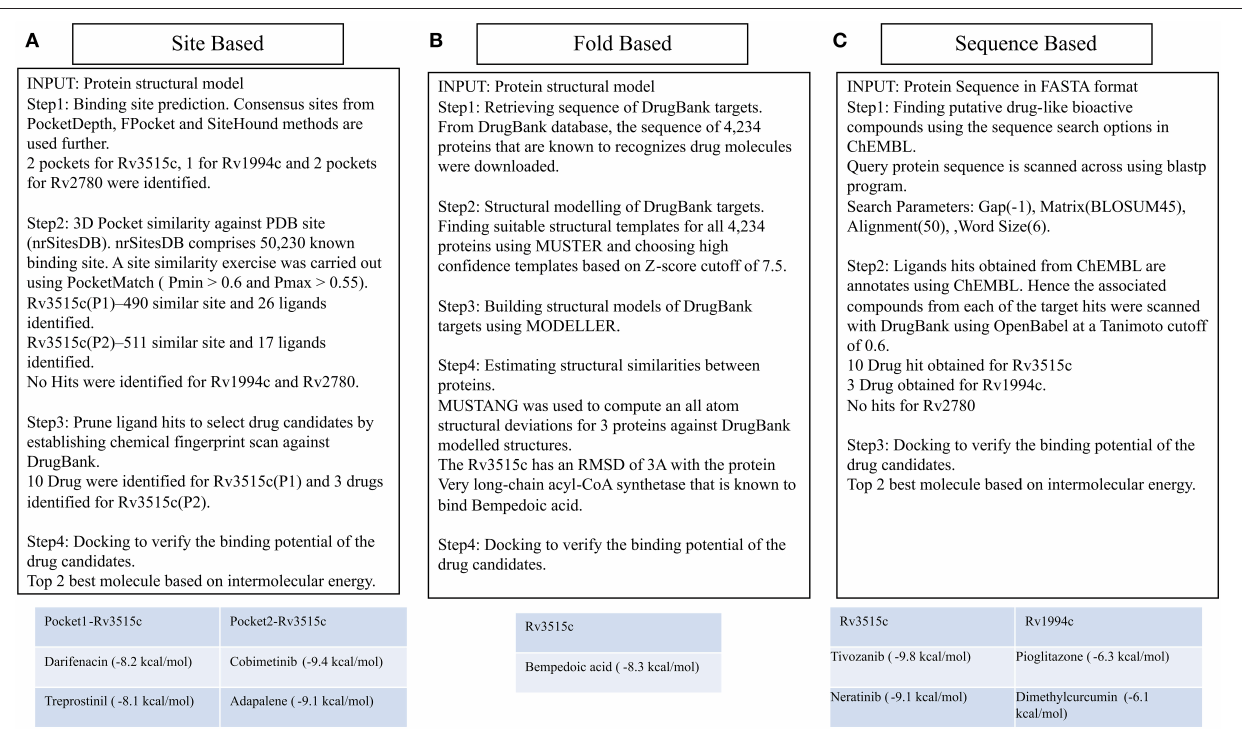
FIGURE 5 | Different ways of associating targets with DrugBank drugs. The site-based association uses binding site similarity as a metric for assigning function to a protein. Consensus pocket prediction exercise yields two pockets for the protein fadD19 (Rv3515c), 1 pocket for cmtR (Rv1994c), and two pockets for ald (Rv2780). Site matching exercise on PDB site library gave 43 ligands that could bind with fadD19. Ligand hits were then pruned by establishing chemical fingerprints on DrugBank molecules. Cobimetinib and darifenacin came out as the best repurposable drug candidate for fadD19. No hits were identified for ald and cmtR. Fold based annotation involves mapping drugs to the targets from the known drug binding proteins. The 3D structure of 4,234 proteins was built using MUSTER and MODELER, of which one hit, very long-chain acyl-CoA synthetase, binding to bempedoic acid share a fold level similarity with fadD19. No hits were identified for ald and cmtR. Finally, sequence derived analysis uses the sequence search option in ChEMBL to identify bioactive compounds. 10 drugs were identified for fadD19, 3 for cmtR. No hit was obtained for